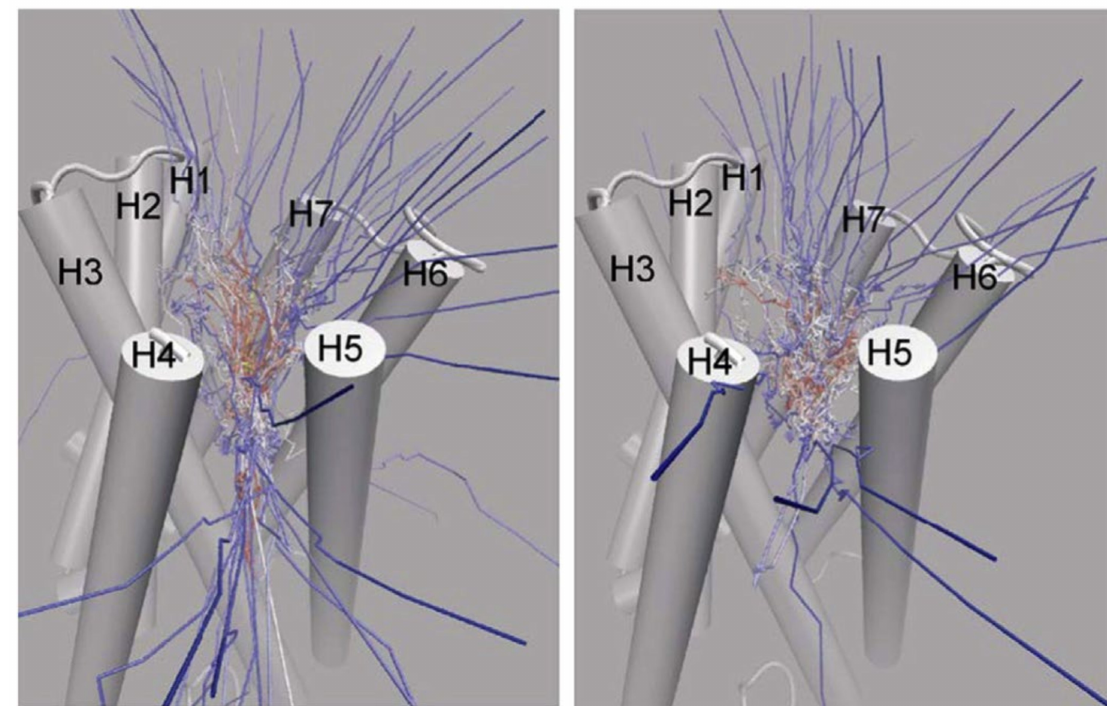
Figure 20. Entry/exit pathways of carazolol observed in the RAMD simulations. Left and right panels show sets of simulations with different acceleration magnitudes. The color scale is from yellow at the beginning of the simulation to blue at the end of the simulation. The starting conformation of the receptor is shown in a cartoon representation. Reproduced with permission from ref.